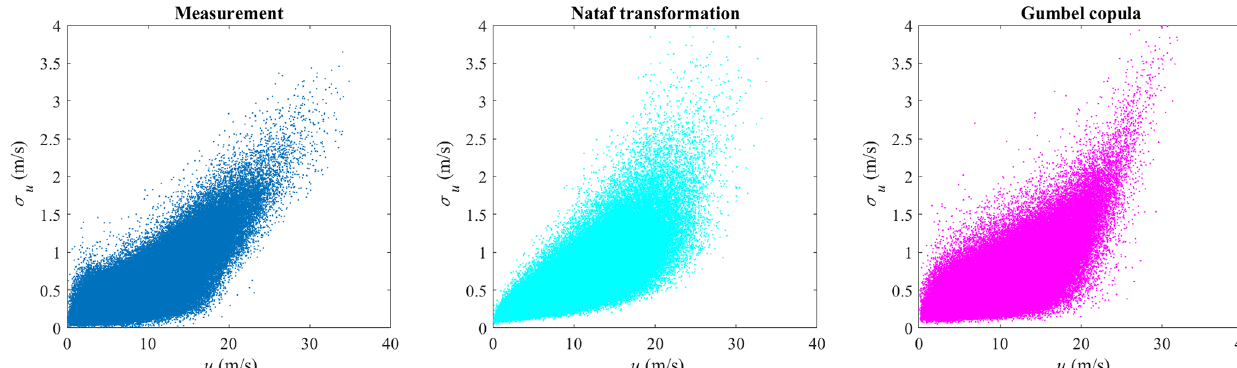
Figure 6. Nataf transformation and Gumbel copula random samples for the offshore sector.